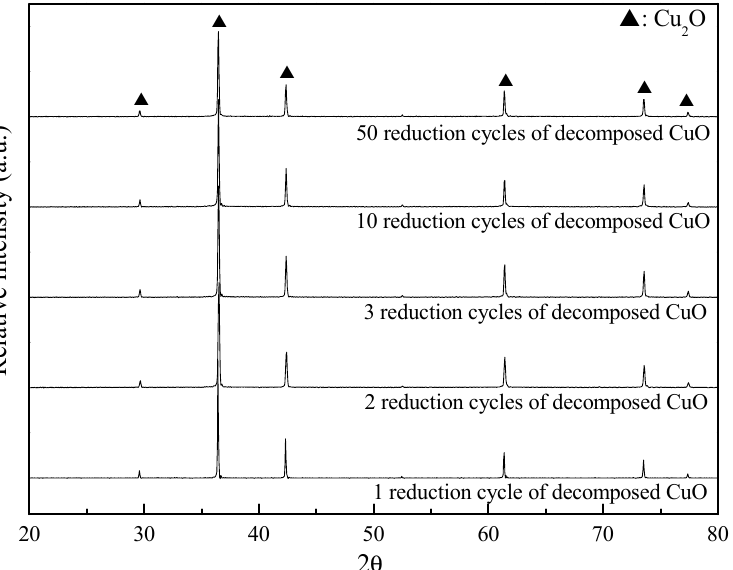
Figure 2. XRD patterns of decomposed CuO during 1, 2, 3, 10, and 50 redox cycles under nitrogen atmosphere at 950 °C.